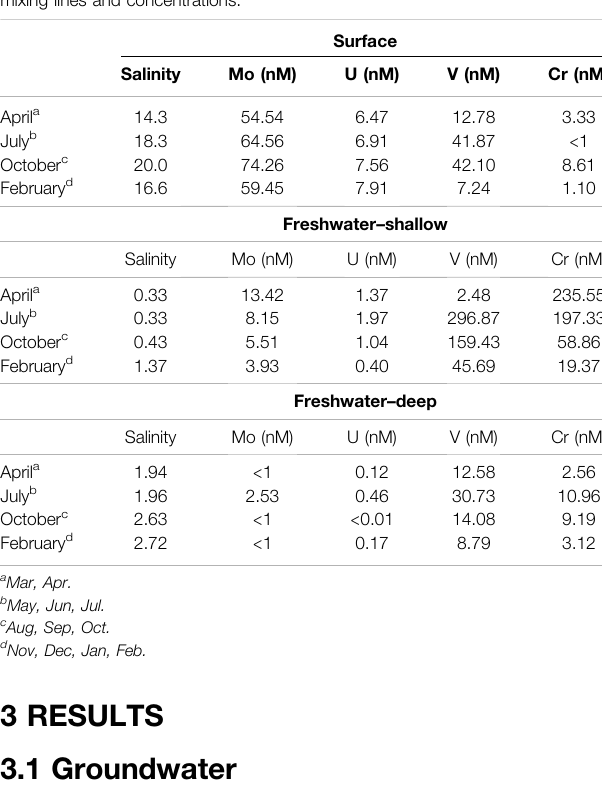
TABLE1| EndmembersalinitiesandRSMconcentrationsusedtoestimatemixing and concentrationanomalies. Thenotesidentifythemonths correspondingto the endmember concentrations that were used to calculate the conservative mixing lines and